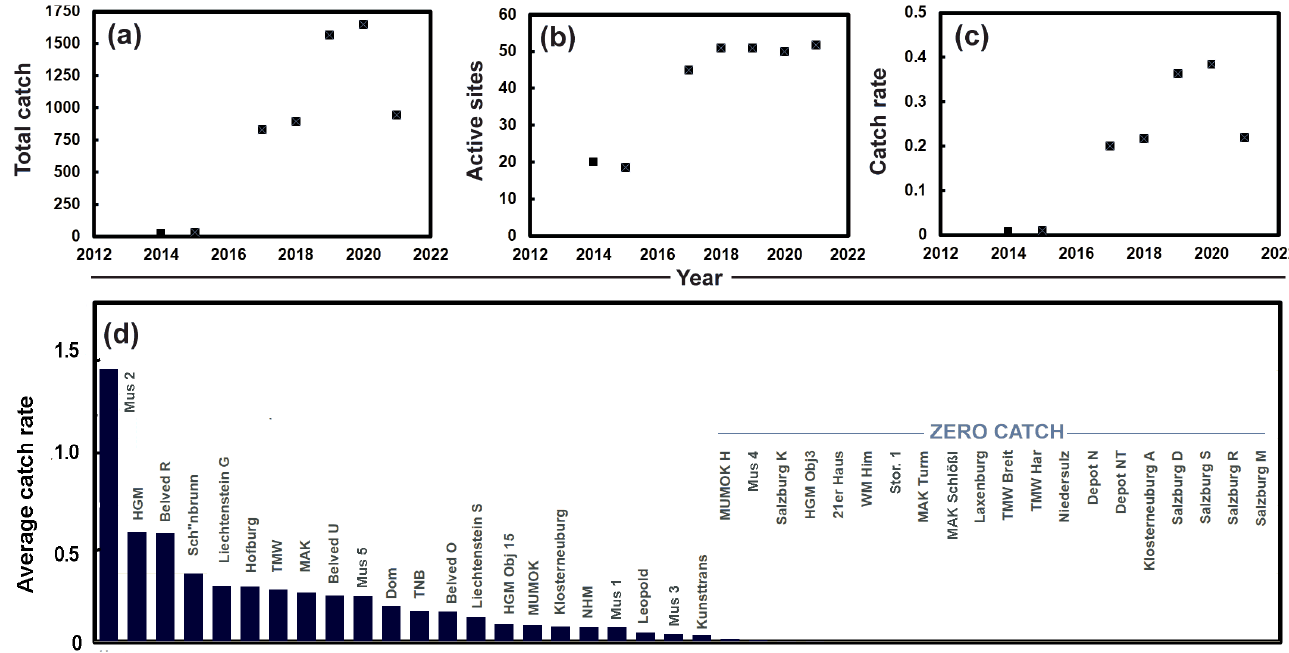
Figure 4. Catch of Ctenolepisma calvum in Austrian museums: ( a ) total annual catch; ( b ) percentage of Austrian museums finding C. calvum ; ( c ) catch rate in Viennese museums; ( d ) average catch rate in Austrian museums (i.e., sum of catches in 2014, 2015, 2017–2021 divided by number of traps deployed at each site). Note: abbreviations are listed in Supplement Table S1.